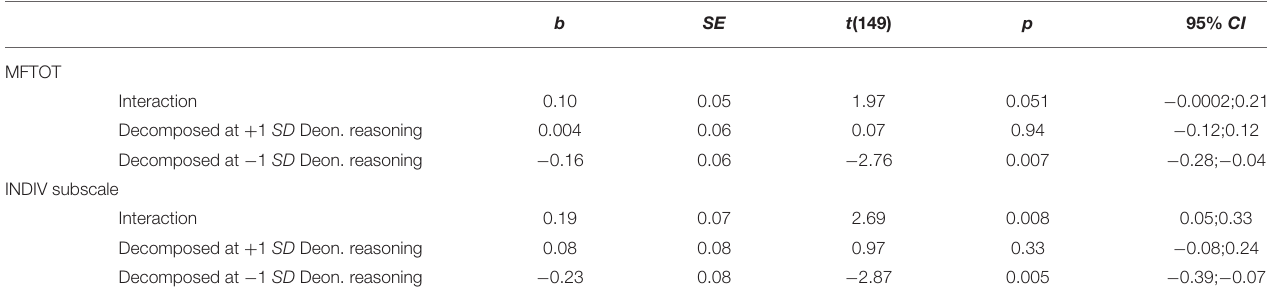
TABLE 3 | Study 1 interaction effects of language × reasoning style (continuous) regression on MFQ total scores, and individuating